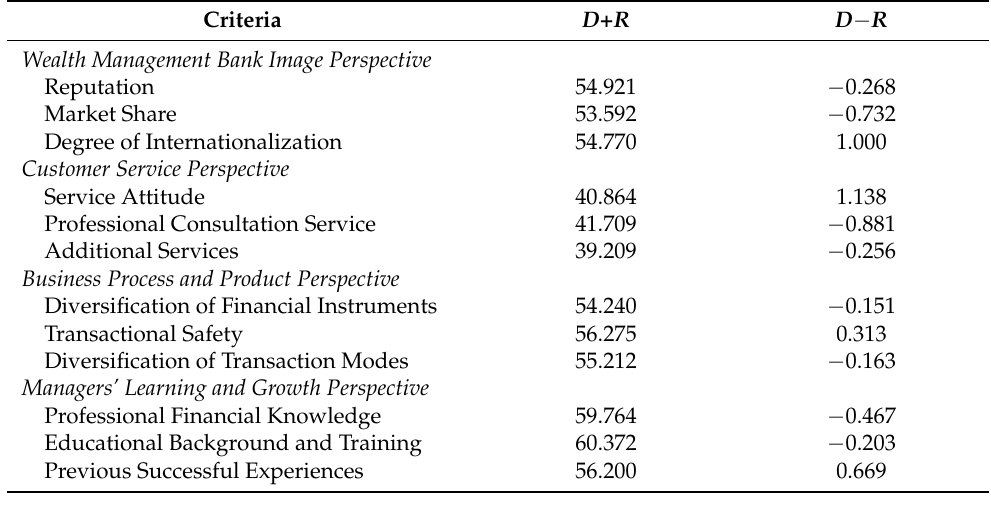
Table 3. Direct and indirect effects of the criteria under evaluation dimensions.